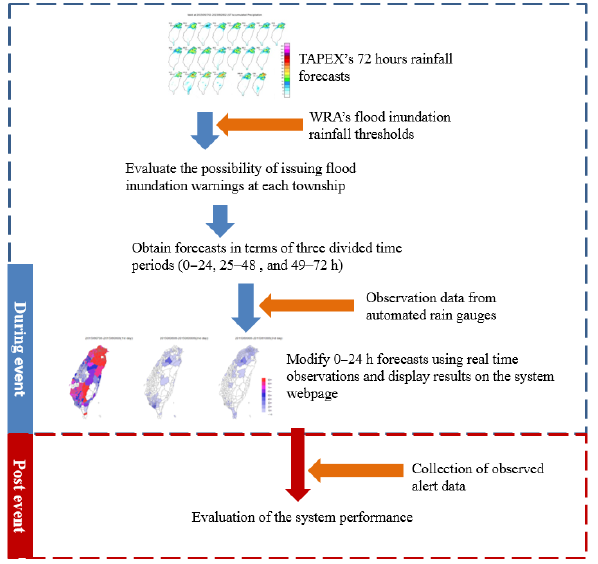
Figure 1. The operational flow chart for the proposed urban inun- dation early warning system.